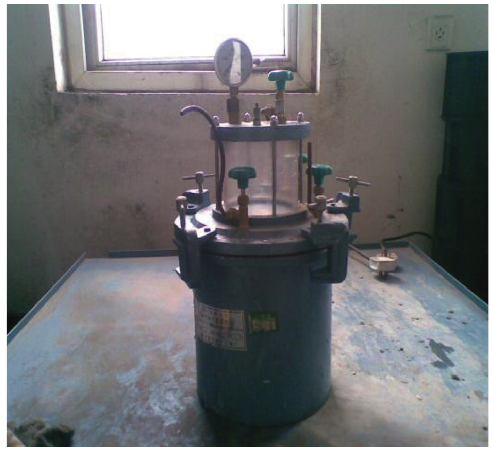
Figure 2: The gas content